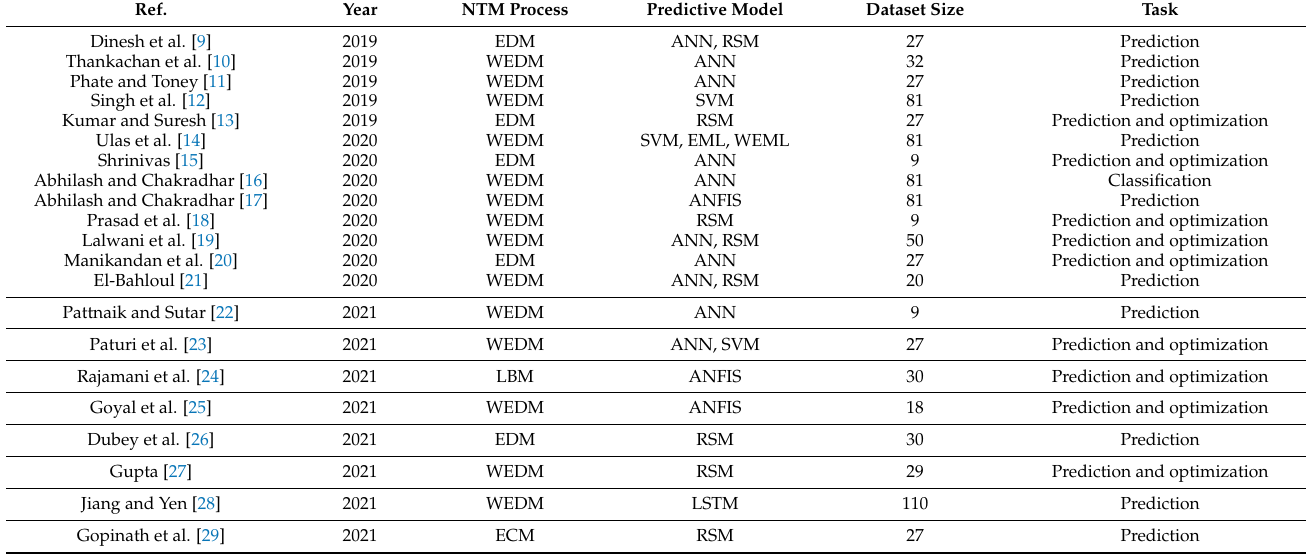
Table 1. Literature on predictive modelling of NTM processes in last 3 years.